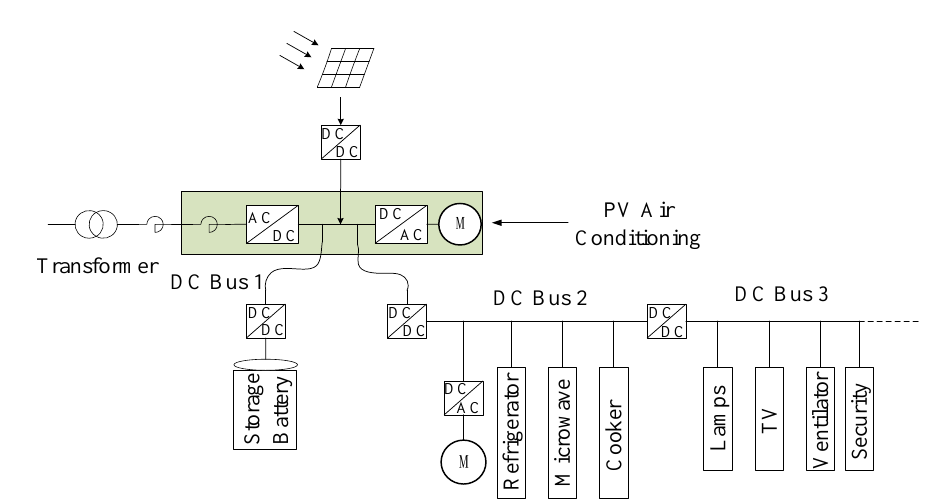
Figure 19. Configuration of Gree Photovoltaic Cabin.